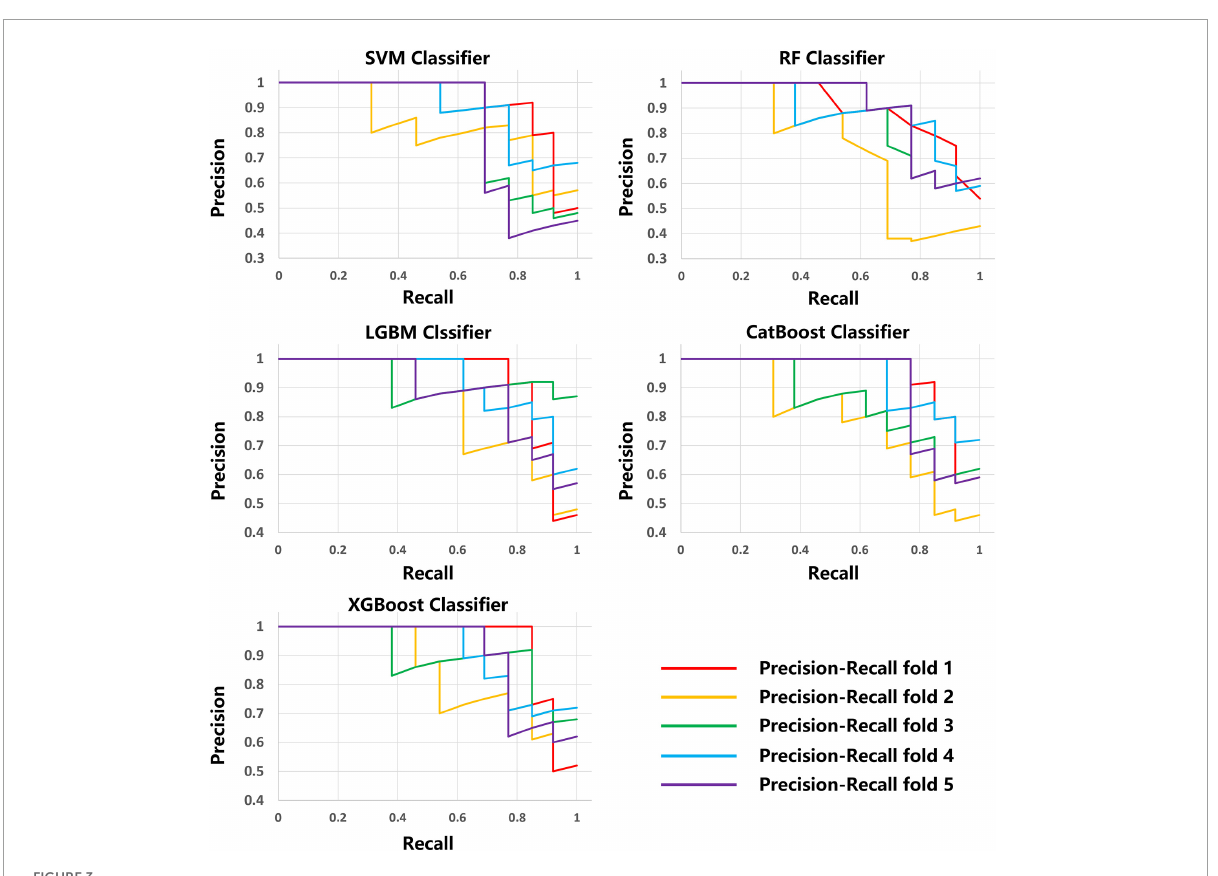
FIGURE3 Precision-recall curves of the five models on five-fold